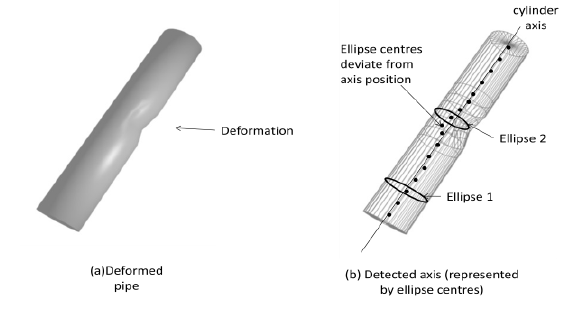
Figure 8. Detecting deformations in piping elements